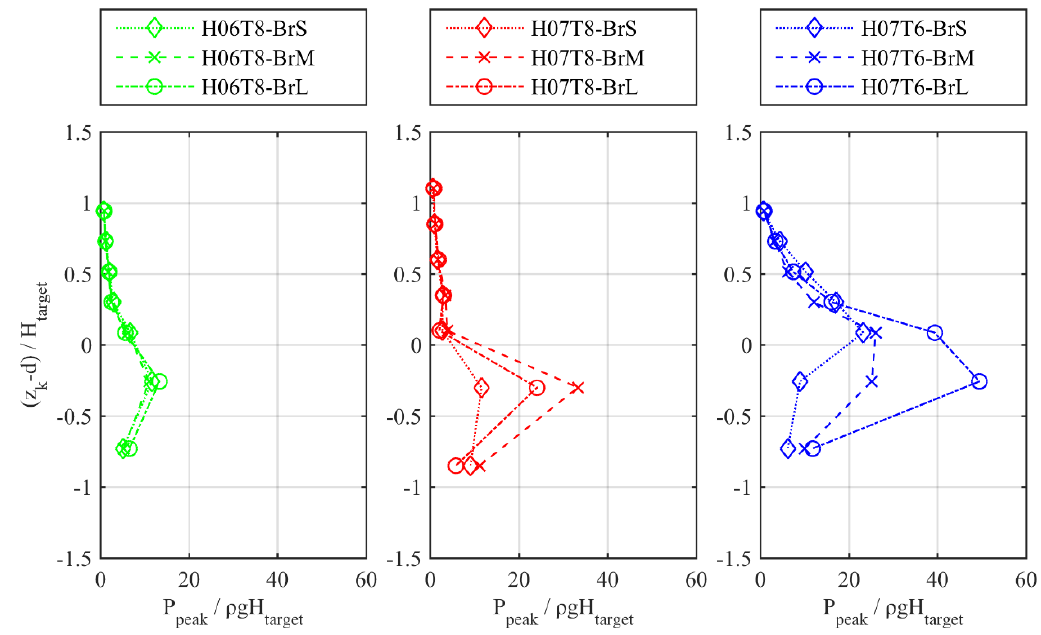
Figure 10. Mean peak pressures at each measuring location for pulsating conditions. Left: H07T4; middle: H05T8; right: H06T6.